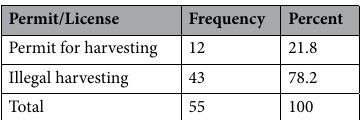
Table 7. SMFEs with Permits/Licenses for Harvesting Raw Materials.